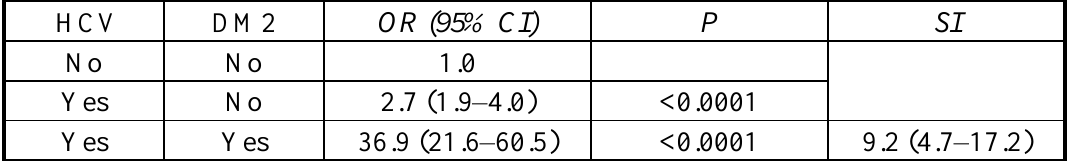
Table 6. Interactive effect of the association of type 2 Diabetes Mellitus with HCV infection in HCC versus Controls group.